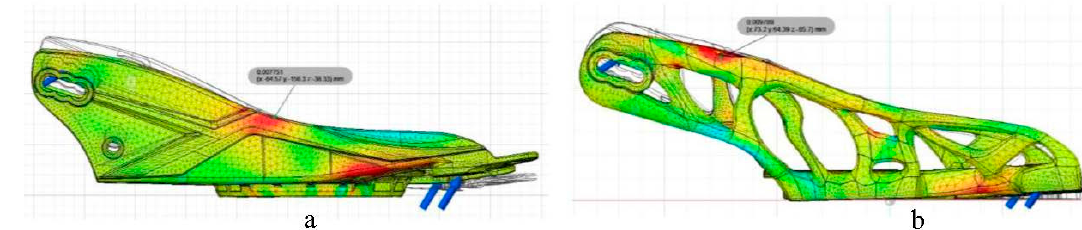
Figure 5. Autodesk Fusion 360 output for the topological optimization of the binding.